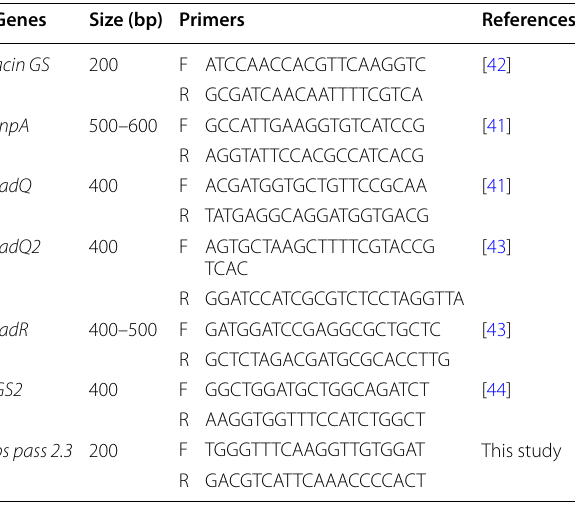
Table 1 Primers used in this study to detect the PAHs biodegrading